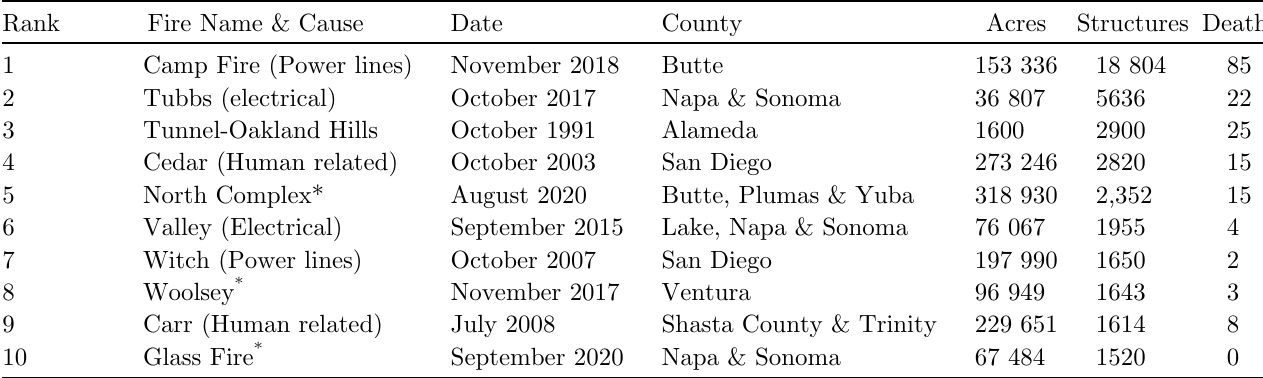
Table 1. Top 10 most destructive in California wild fi